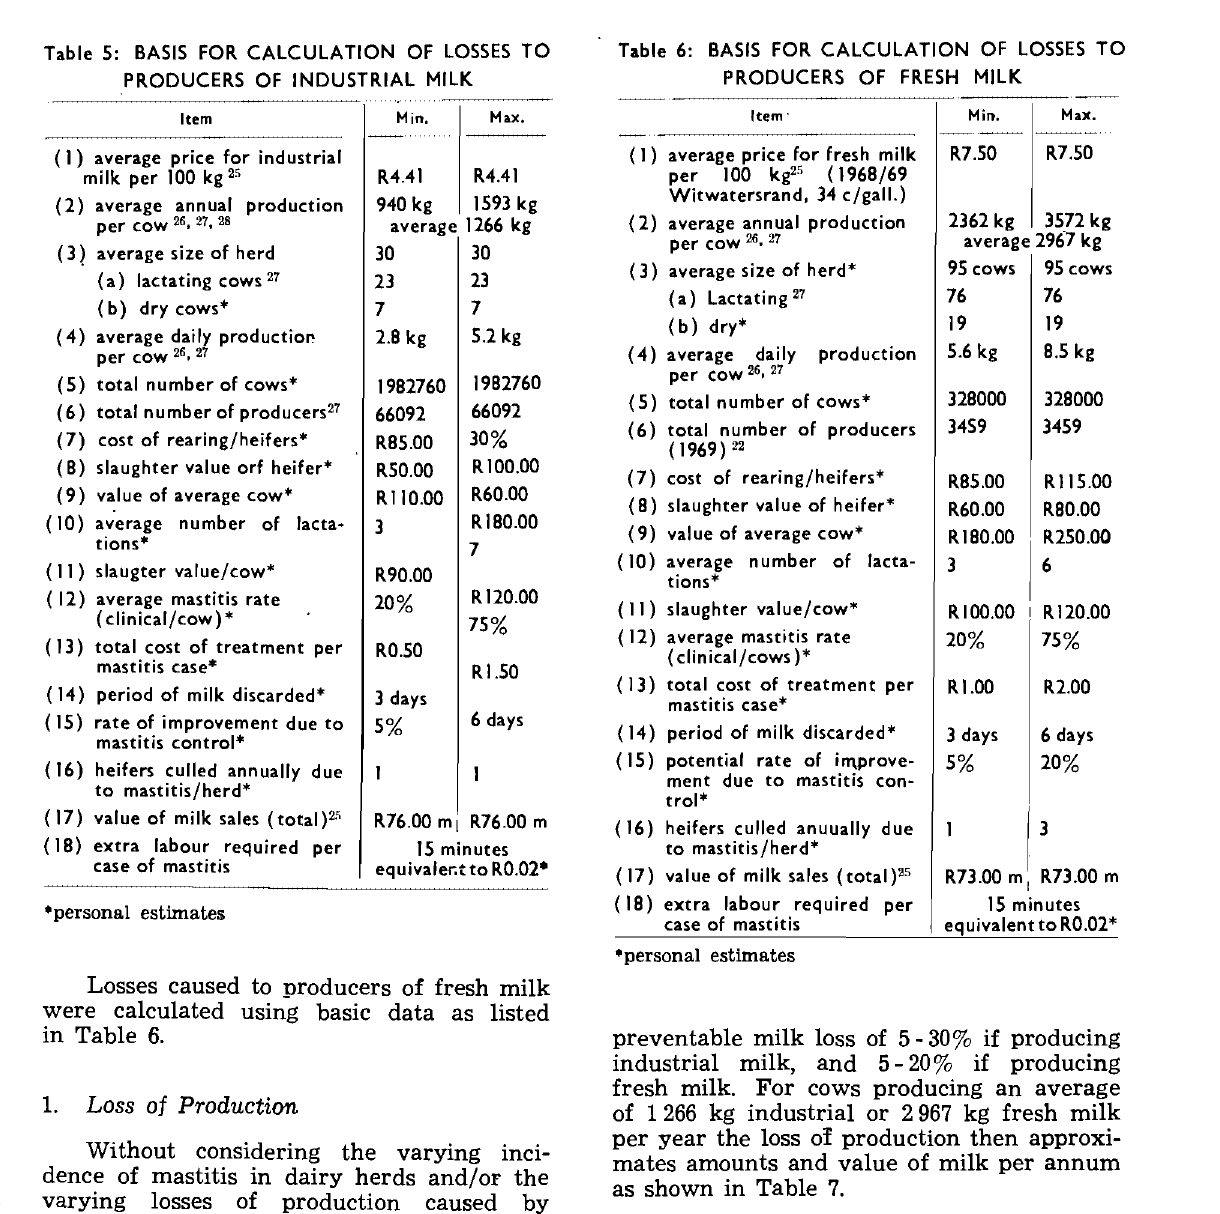
Table 7: ESTIMATED ANNUAL LOSS